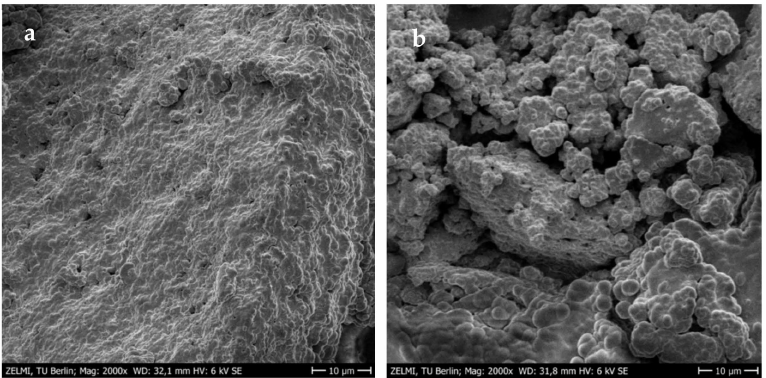
Figure 4. SEM images of 1.76% TEO-NE-containing yogurt gels treated with ( a ) and without 0.5 U/g MTGase ( b